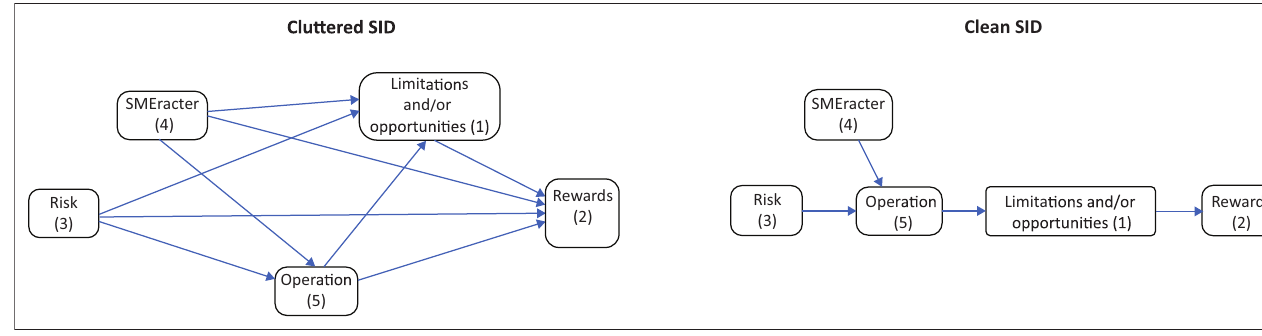
FIGURE 2: Cluttered system influence diagram and clean system influence diagram.